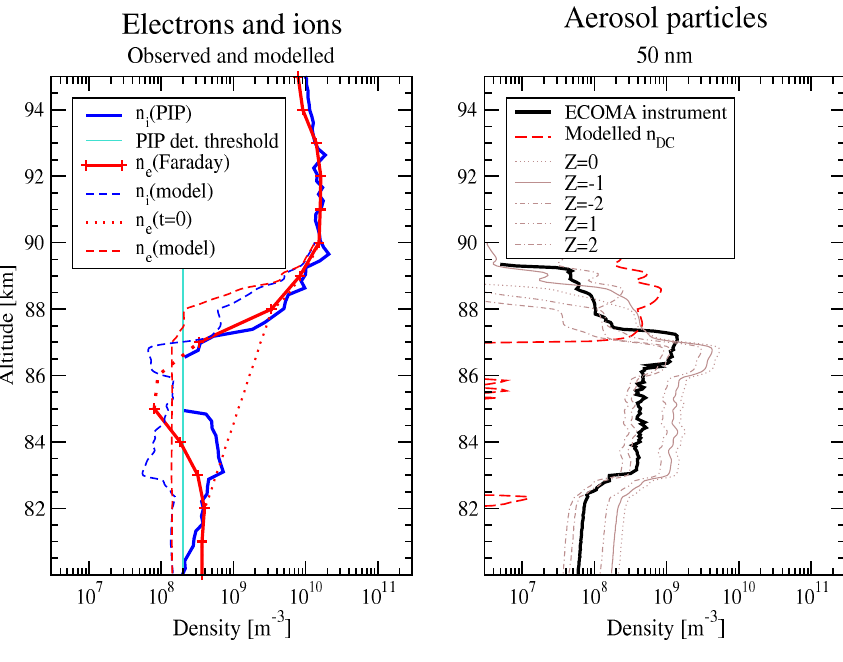
Fig. 5. Model results assuming α = α c , r a = 50nm, I a = 0 . 3s − 1 , charge states Z =− 5 through Z = 3, and an aerosol particle density which is 10 times the charge density measurement of the ECOMA